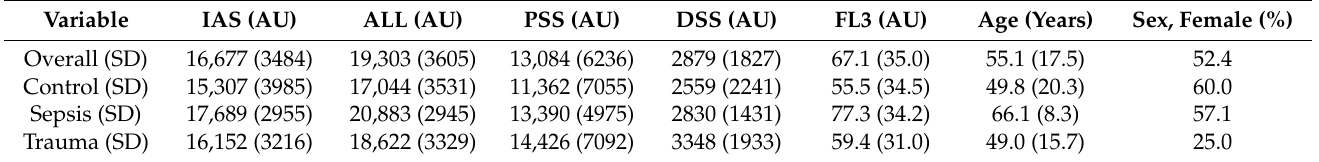
Table 1. Means (SD) of hematology characteristics, age, and